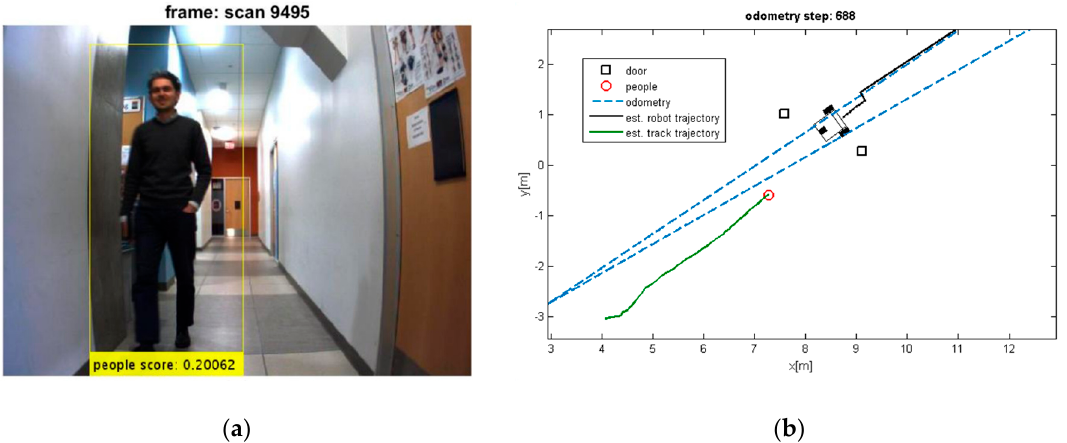
Figure 10. ( a ) Detected moving people; ( b ) Estimated trajectories of robot and tracks along with the estimated position of doors.